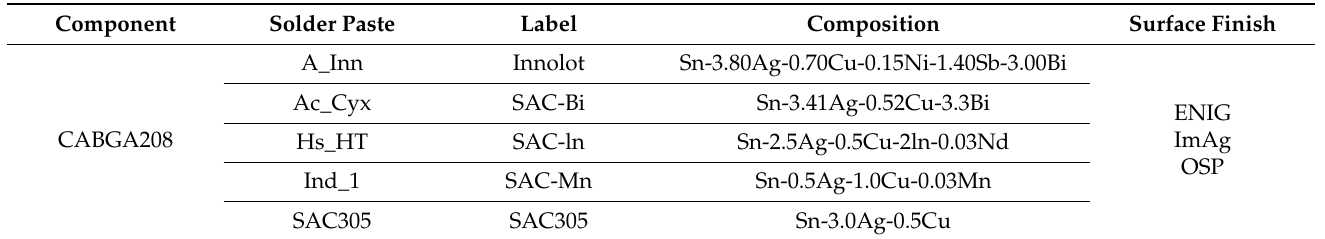
Table 2. Composition and testing matrix of solder alloys.